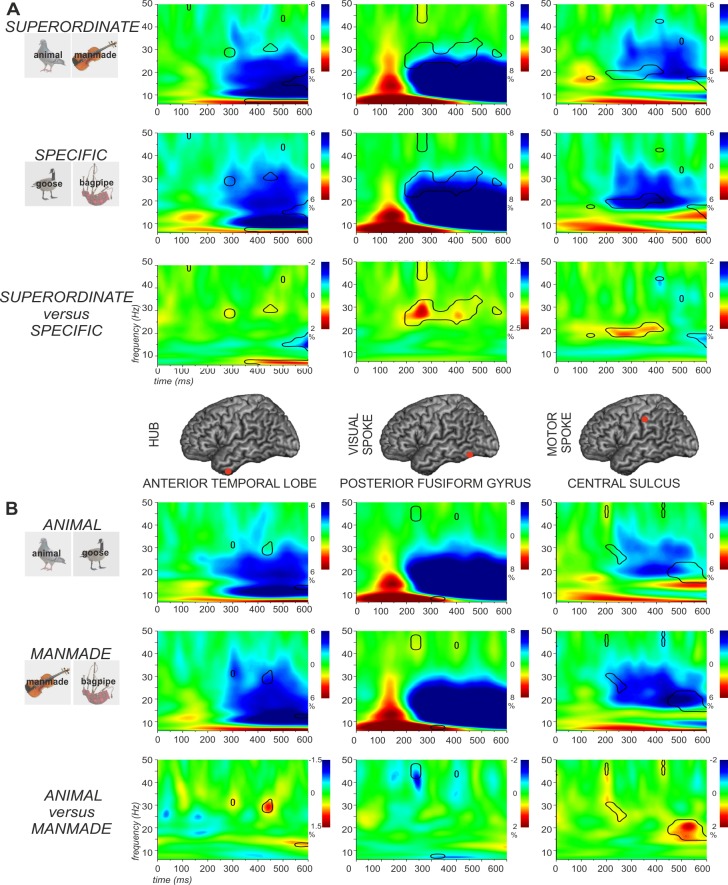
Time-frequency plots for each cortical site (ATL, FG, and CS) are presented in each column.(A) Main effect of specificity. (B) Main effect of category. In both (A) and (B), the first and second row report the percentage signal change in total power for each condition, relative to their passive periods. The third row shows differences between the two conditions. The black lines in the time-frequency plots indicate regions showing significant differences between the two conditions (p < .05). See text for details.